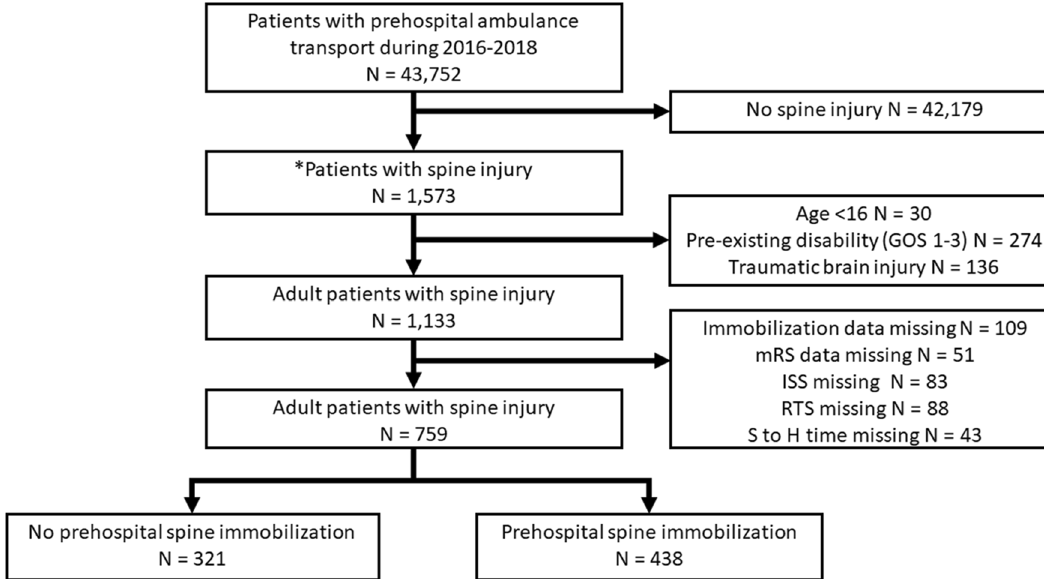
Figure 1. Flow diagram of patients included in our study. GOS Glasgow outcome scale, mRS modified Rankin Scale, RTS revised trauma score, StoH time Scene-to-hospital time. *Patients with spinal injury were defined as meeting the diagnosis of ICD-9 or 10 described in the